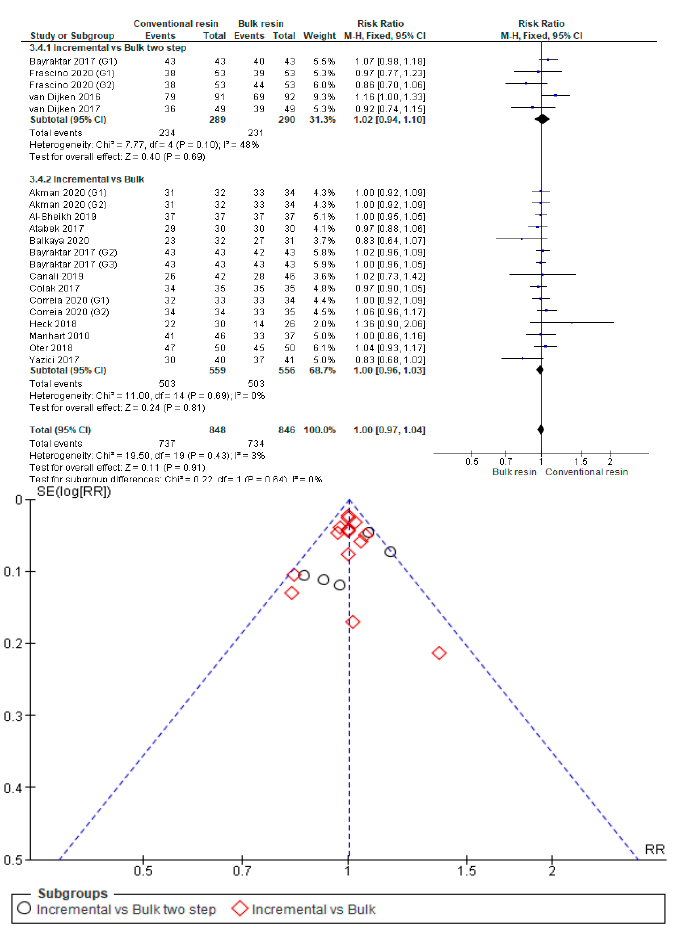
Figure A14. Adequate Marginal Adaptation: Conventional Resin versus Bulk Resin According to the Technique Used.